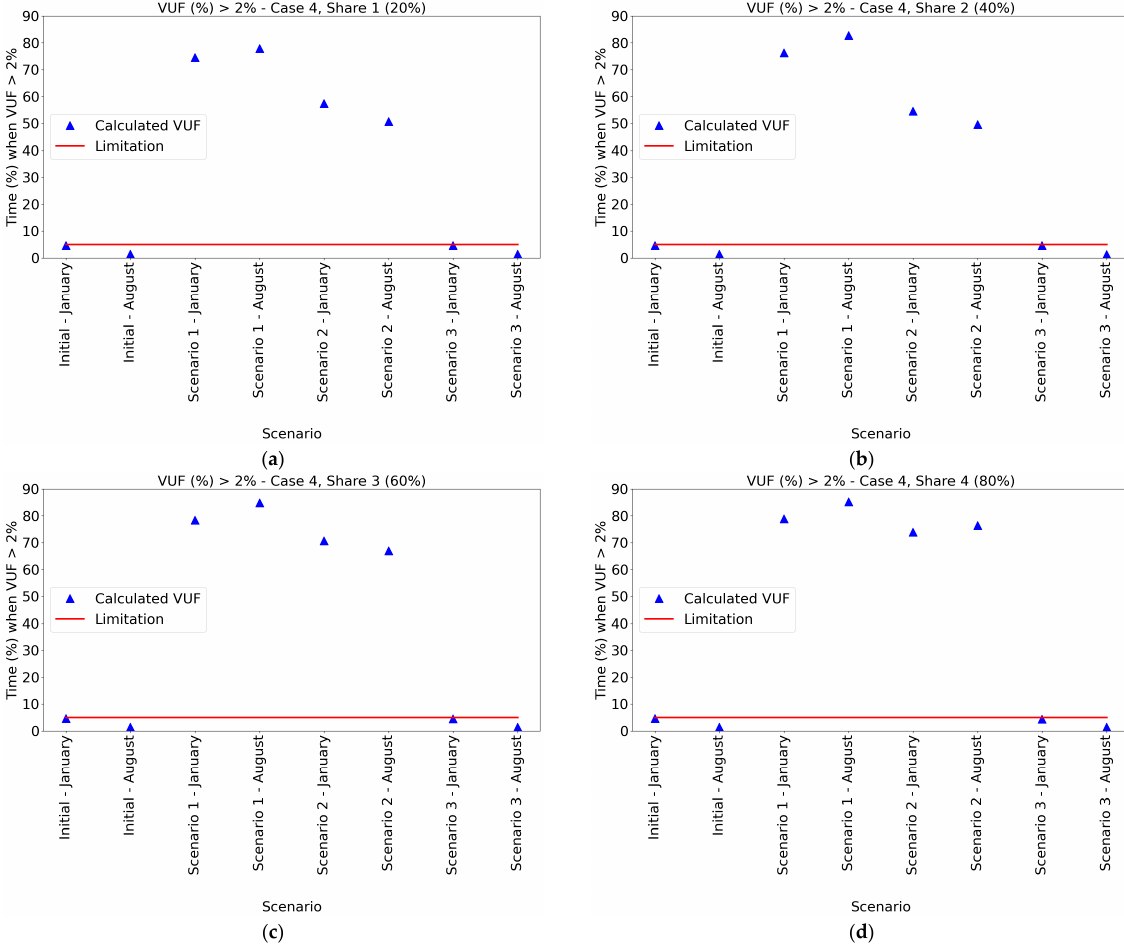
Figure 9. VUF > 2%—Case 4; Share 1–Share 4; January, August.